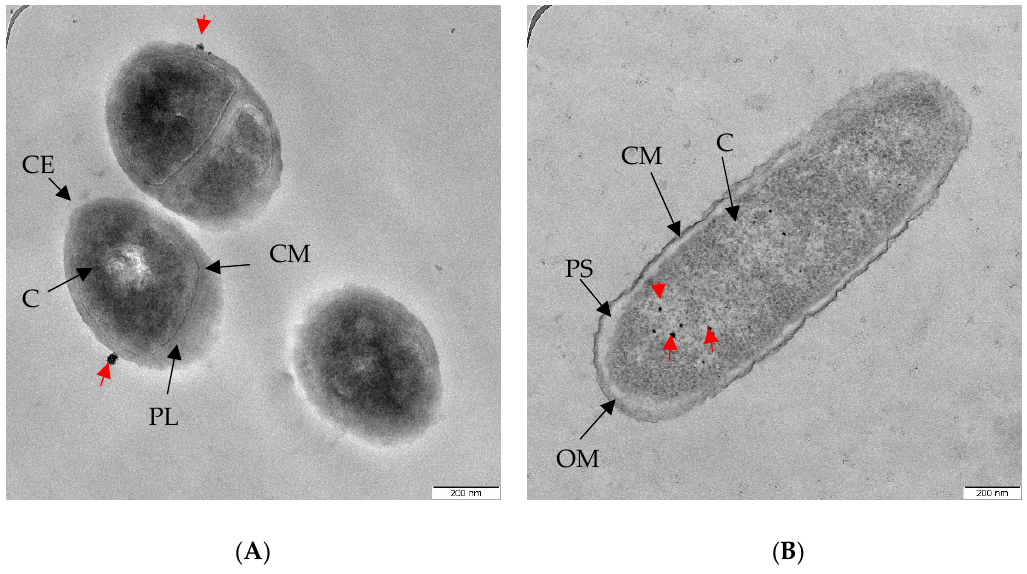
Figure 5. TEM images show bioAgNPs ( A ) that accumulated on the clinical MRSA envelope, and ( B ) were internalized in the P. aeruginosa USM-AR2 cytoplasm. Red arrows indicate the presence of bioAgNPs. CE, cell envelope; PL, peptidoglycan layer; CM, cytoplasmic membrane; C, cytoplasm; OM, outer membrane; PS, periplasma space.